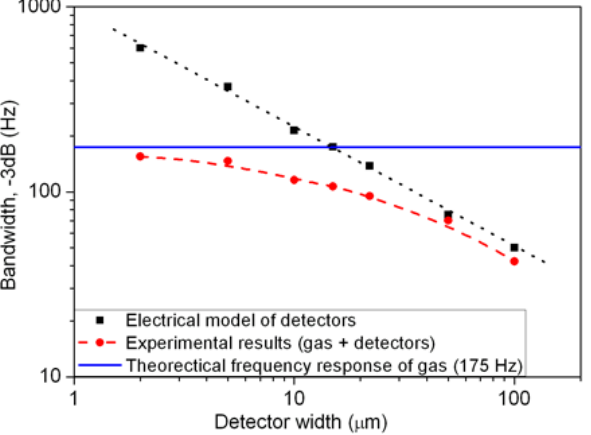
Figure 7. Experimental sensor bandwidth, experimental detector bandwidth (confirmed by the electrical model) and theoretical frequency response of gas vs. the detector width.